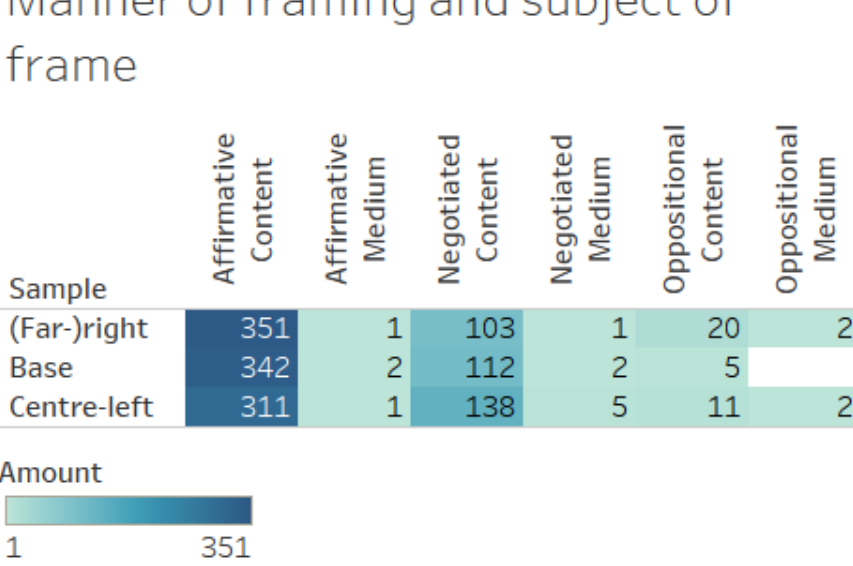
Fig. 2. Manner of framing and subject of